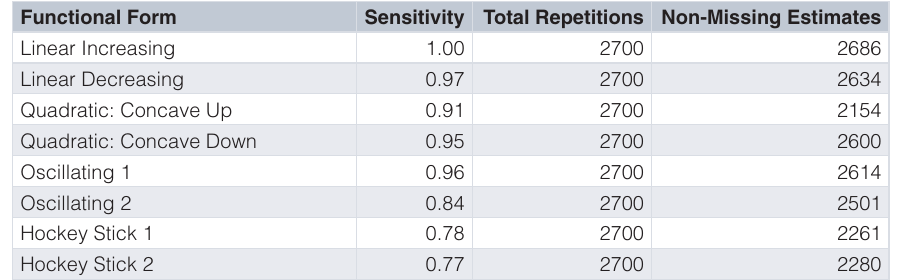
Table 1. Estimated sensitivity from metaSplines method for data simulated from each respective functional form for a total of 100 repetitions across 27 different parameter settings fixing the correlation structure to be AR(1) with ρ = 0.7. Parameter values used: σ ∊ {1, 2, 4}, n